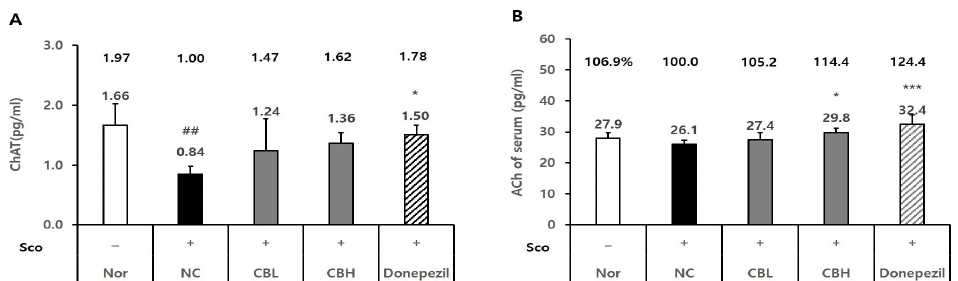
Figure 3. Effects of CB extract on the levels of ( A ) hippocampal ChAT and ( B ) serum ACh level of chronically scopolamine-treated rats. Rats were randomly divided into five groups. Nor; normal, commercial diet + saline; NC, negative control (Sco), commercial diet + Sco in saline; CBL, CB extract 0.07% diet + Sco in saline; CBH, CB extract 0.14% diet + Sco in saline; Do, commercial diet + 1 mg/kg Donepezil in saline + Sco in saline (n = 3 for ChAT and ACh). Sco at 1 mg/kg was administered to rats one time per day for 21 days (i.p). Significance was determined by one-way ANOVA with post hoc Tukey’s multiple comparison test; Data are means ± standard errors of the mean (SEM). ## p < 0.01 significance compared with the control (white bar). * p < 0.05, *** p < 0.001 significance compared with Sco-treated groups (black bar).